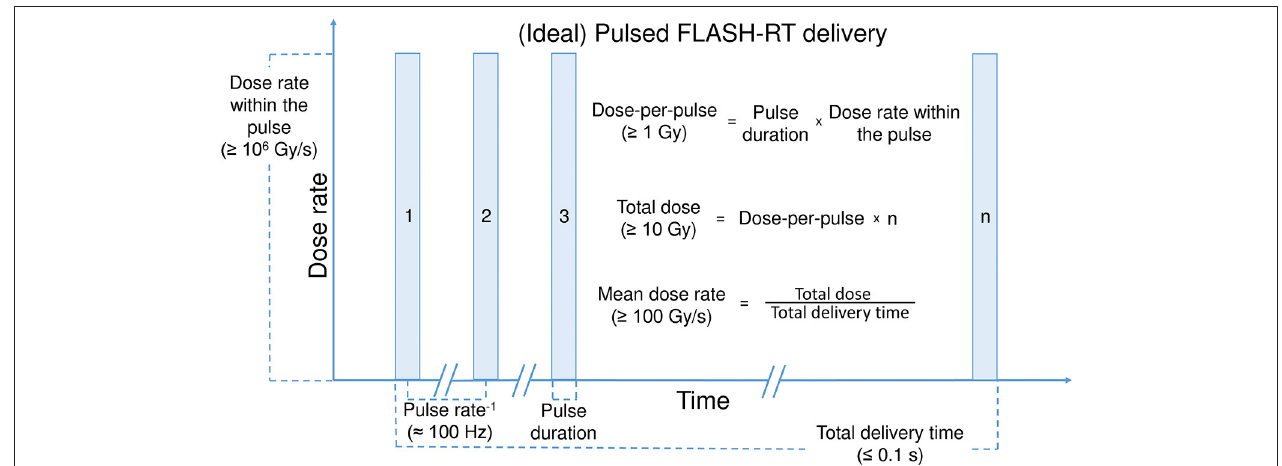
FIGURE 1 | (Ideal) Pulsed FLASH-RT delivery. A schematic view of a pulsed beam delivery, specifying some parameters which seems to be important for inducing the FLASH effect.